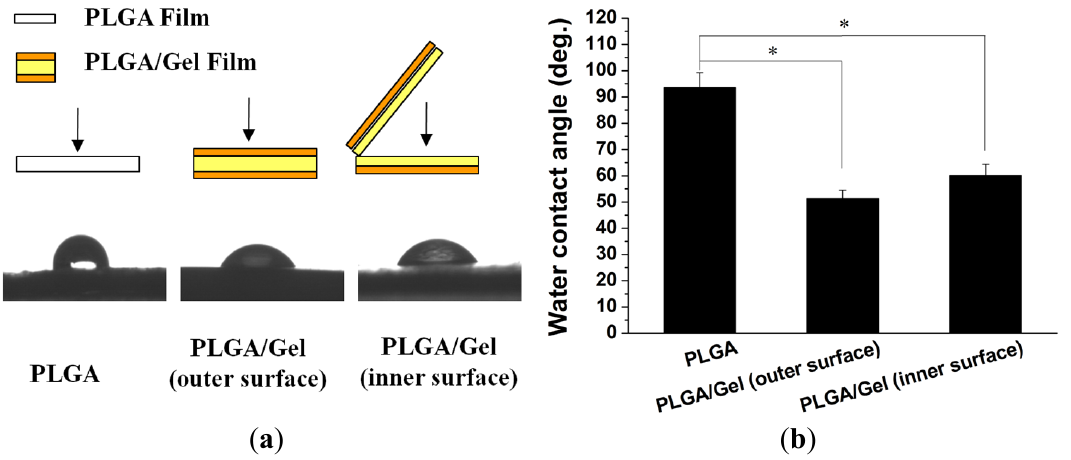
Figure 6. Test methods ( a ) and results ( a , b ) of water contact angles on outer and inner surfaces of PLGA and PLGA/Gel scaffolds. The data were represented as mean ± standard deviation (SD; n = 3; * p <